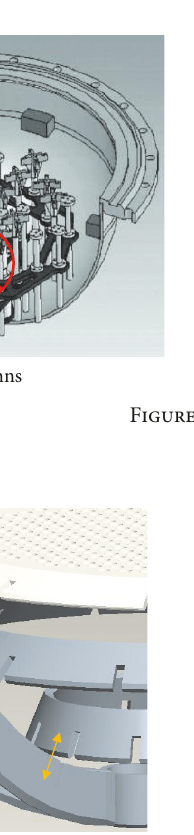
Figure 6: Illustration of vortex suppression plates